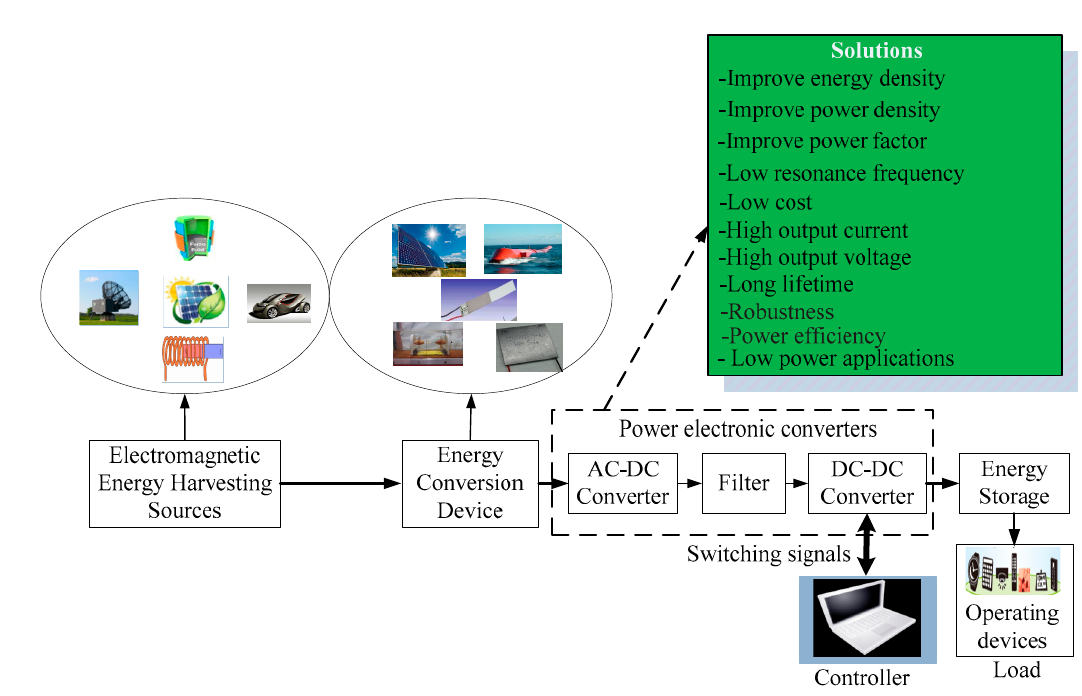
Figure 2. The typical block diagram of EMEH system.